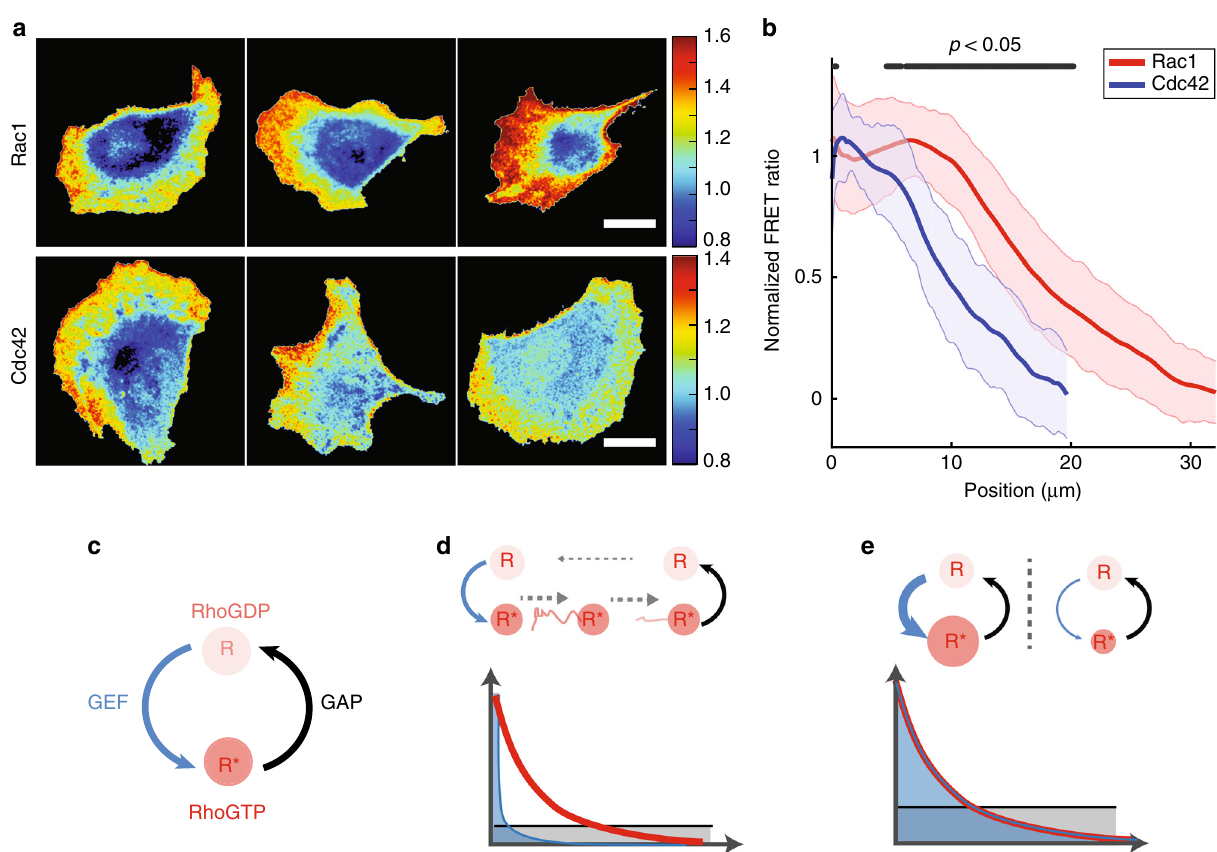
Fig. 1 Rac1 and Cdc42 activity gradients have different shapes. a FRET biosensors were used to monitor Rac1 (top) or Cdc42 (bottom) activity in freely migrating HeLa cells. GTPase activity is measured by the FRET ratio, and represented with a color scale. Several representative cells are shown. Scale bar: 20 µ m. b Mean normalized FRET ratio of Rac1 (red) and Cdc42 (blue) is plotted as a function of the distance from the cell edge. The error bars indicate the standard deviation (s.d.) of n = 31 (Rac1) or n = 19 (Cdc42) cells. Black segments at the top show positions at which the curves are statistically